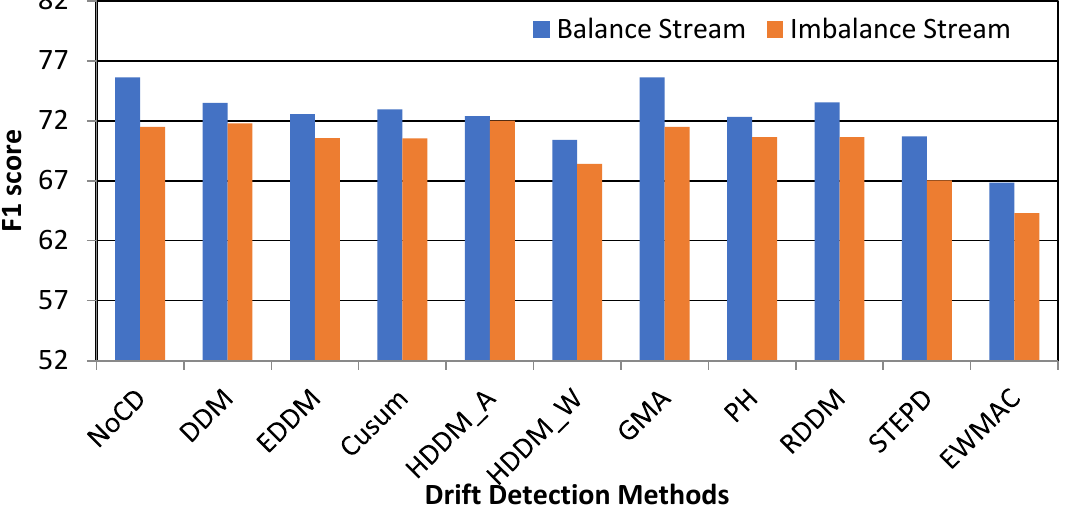
Figure 3. F1 score on balanced and imbalanced data streams with sudden drift.